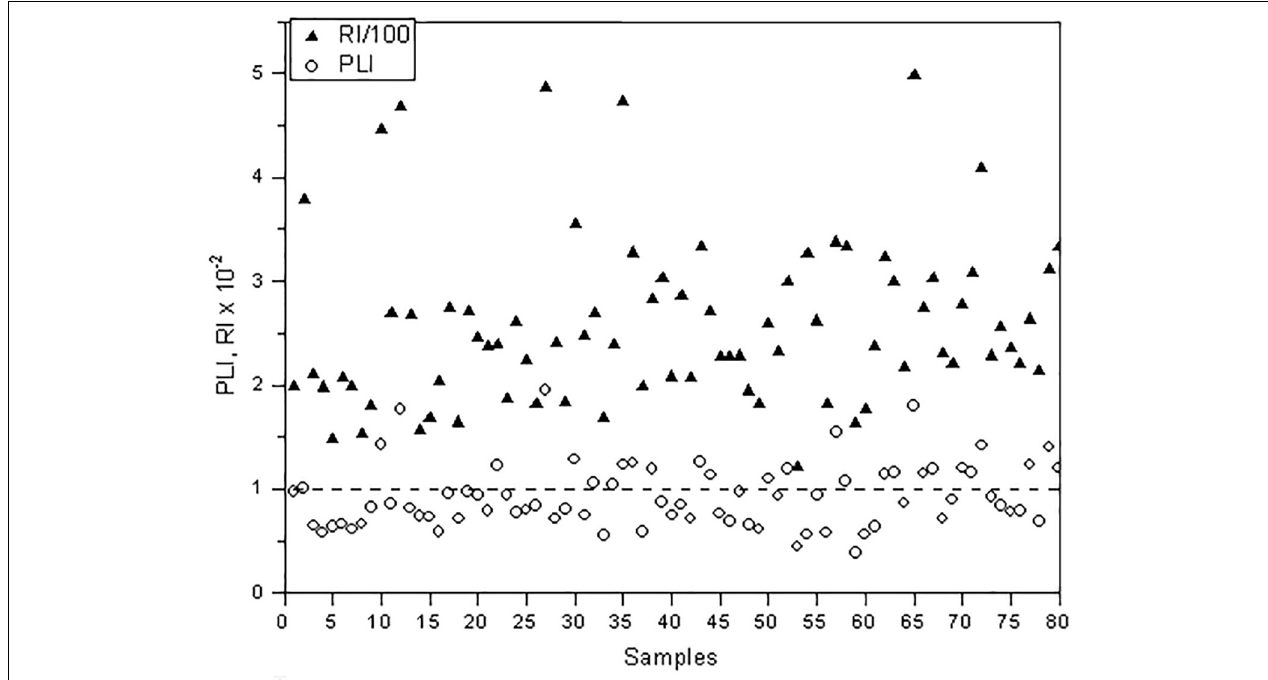
FIGURE 7 | PLI and RI values in the studied area at the former painting production facility.